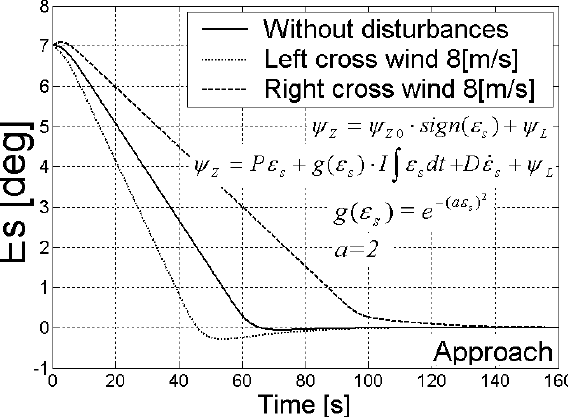
Fig 3b. Simulation results for stabilization with the use of control law based on PID